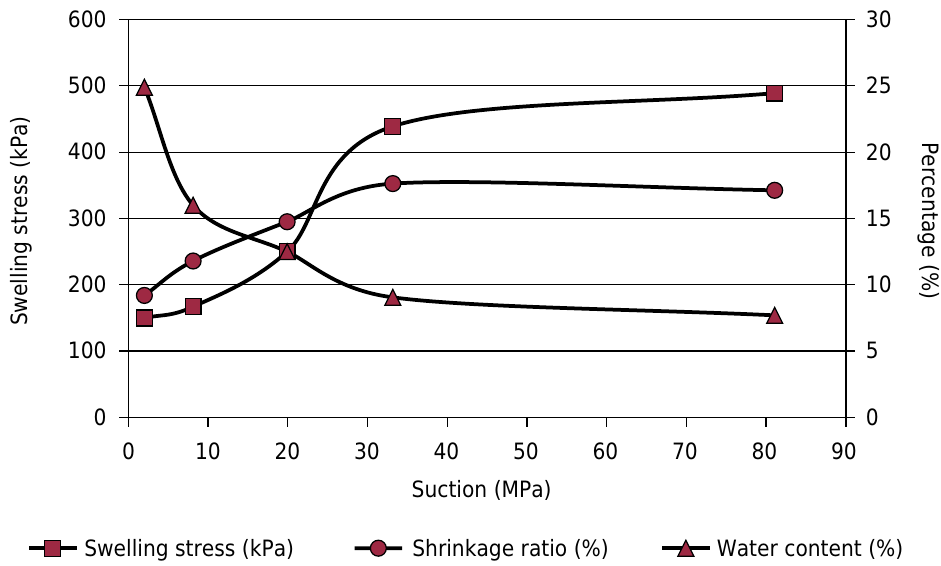
Figure 7. Variation of swelling stress, water content, and shrinkage ratio with